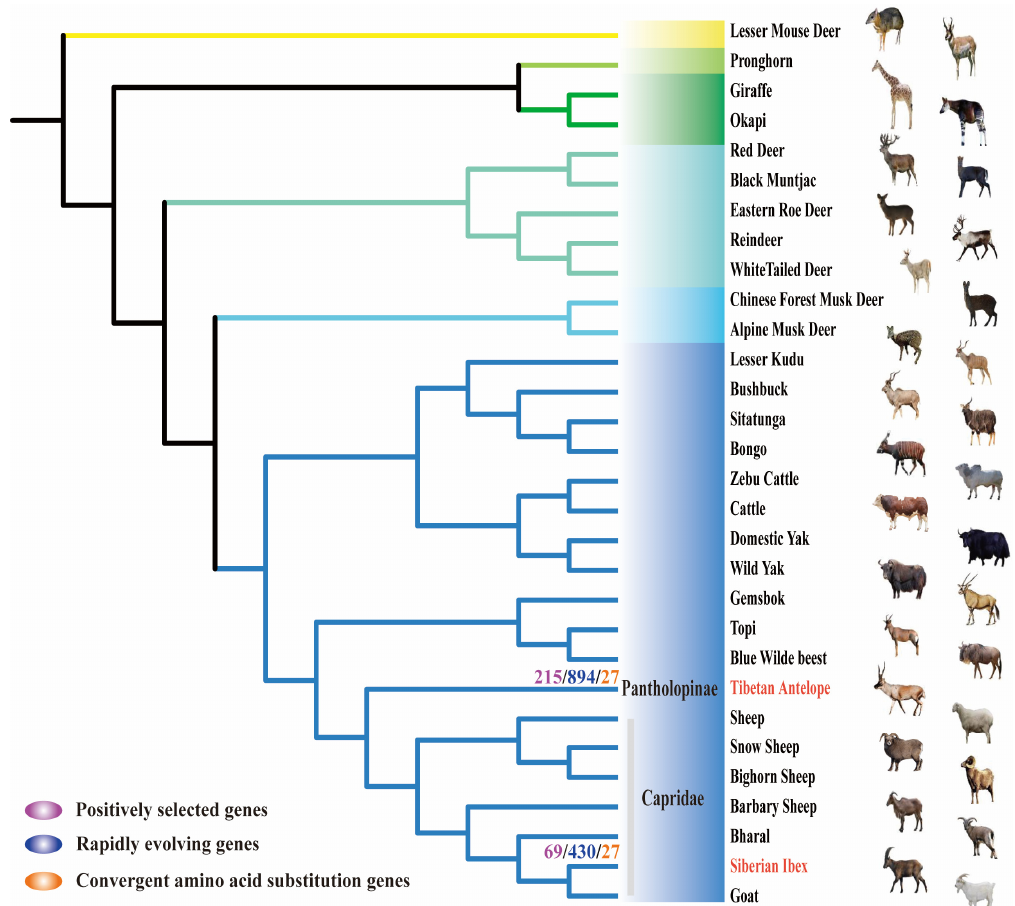
Figure 1. Species phylogenetic tree topology used for selection tests and inference of convergent evolution. The maximum likelihood phylogenetic tree of 30 ruminant species. The Lesser mouse deer is an outgroup. Different branch colors represent different families (including Tragulidae , Antilocapridae , Giraffidae , Cervidae , Moschidae and Bovidae ).